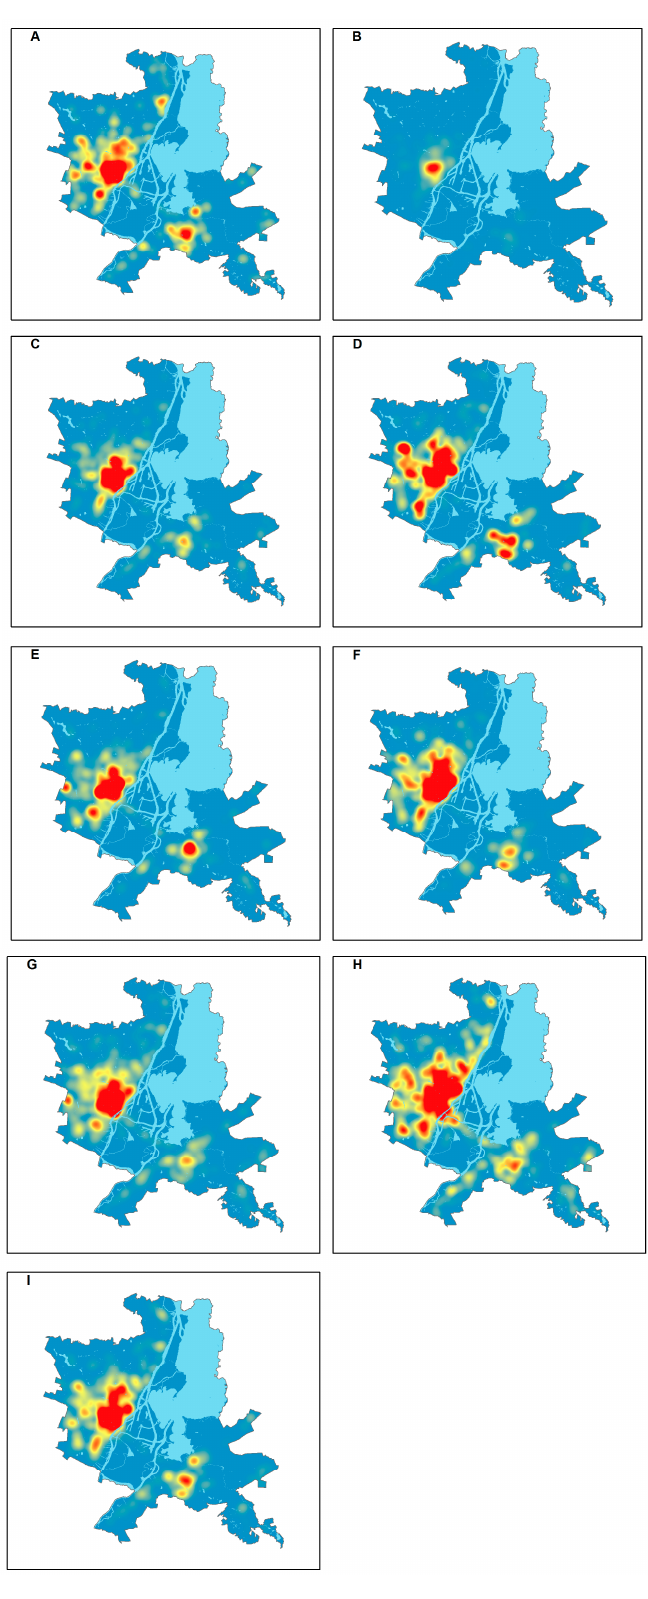
Figure 2. The spatial distribution of crime types in Szczecin from 2006 to 2010. ( A ) Fights and battery; ( B ) Drug crimes; ( C ) Robbery; ( D ) Residential crimes; ( E ) Commercial crimes; ( F ) Car crimes; ( G ) Theft of property—other; ( H ) Burglary in other commercial buildings; ( I ) Property damage.